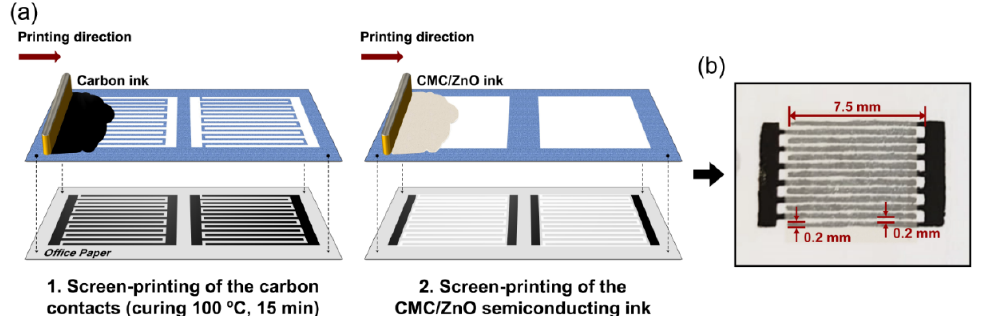
Figure 1. ( a ) Schematic of the fabrication process of the screen-printed CMC/ZnO UV sensor on office paper. ( b ) Optical image of a single screen-printed UV sensor on office paper.